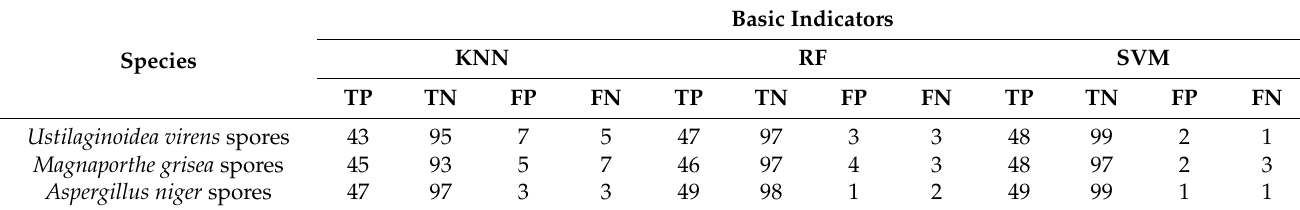
Table 2. Comparative analysis of different classification modes